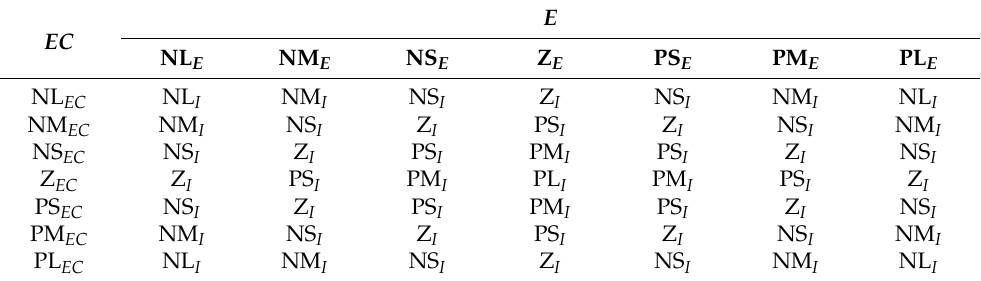
Table 2. Proportional coefficient variation of ∆ I fuzzy control